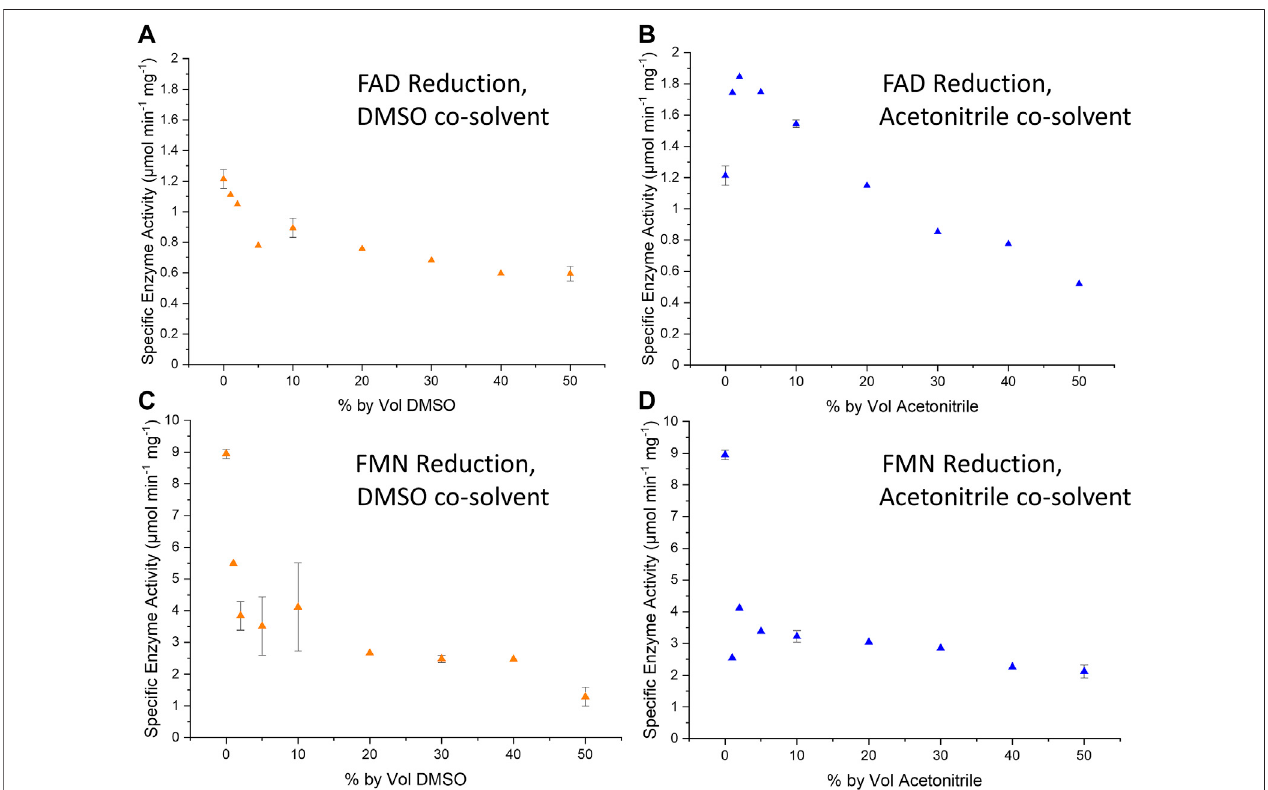
FIGURE 3 | Plots summarising the speci fi c enzyme activity per mg of Hyd1 during the H 2 -driven reduction of FAD (A,B) or FMN (C,D) under various % by volume DMSO (left-hand column) or acetonitrile ( “ MeCN ” , right-hand column). Speci fi c enzyme activity was calculated using the method described in Materials and Methods . The standard deviations of reactions of 0, 10 and 50% by volume are also shown as error bars, as these tests were repeated in triplicate. Reaction conditions: 0.1 mM fl avin cofactor, 10 µL Hyd1 (4.42, 2.50, or 6.38 mg mL − 1 ) in Tris-HCl buffer (50 mM, pH 8.0) and organic solvent, under a continuous fl ow of H